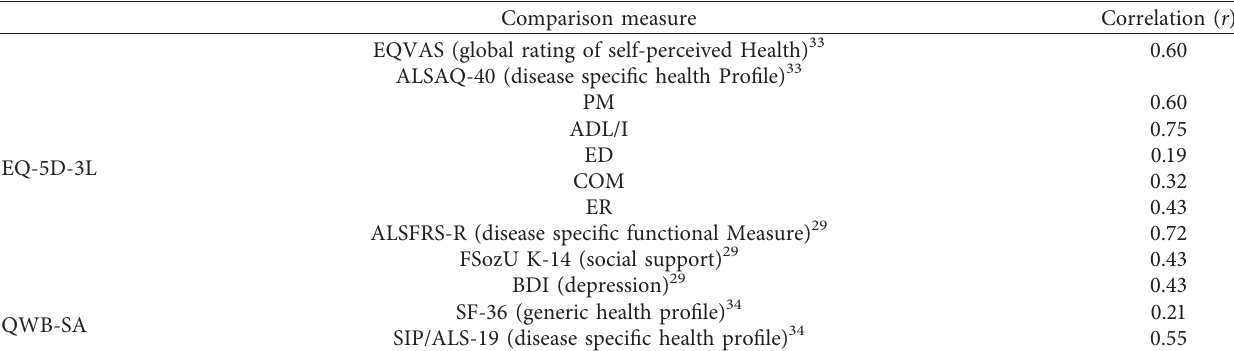
Table 2: Convergent validity of the EQ-5D-3L and the QWB-SA scale. Comparison